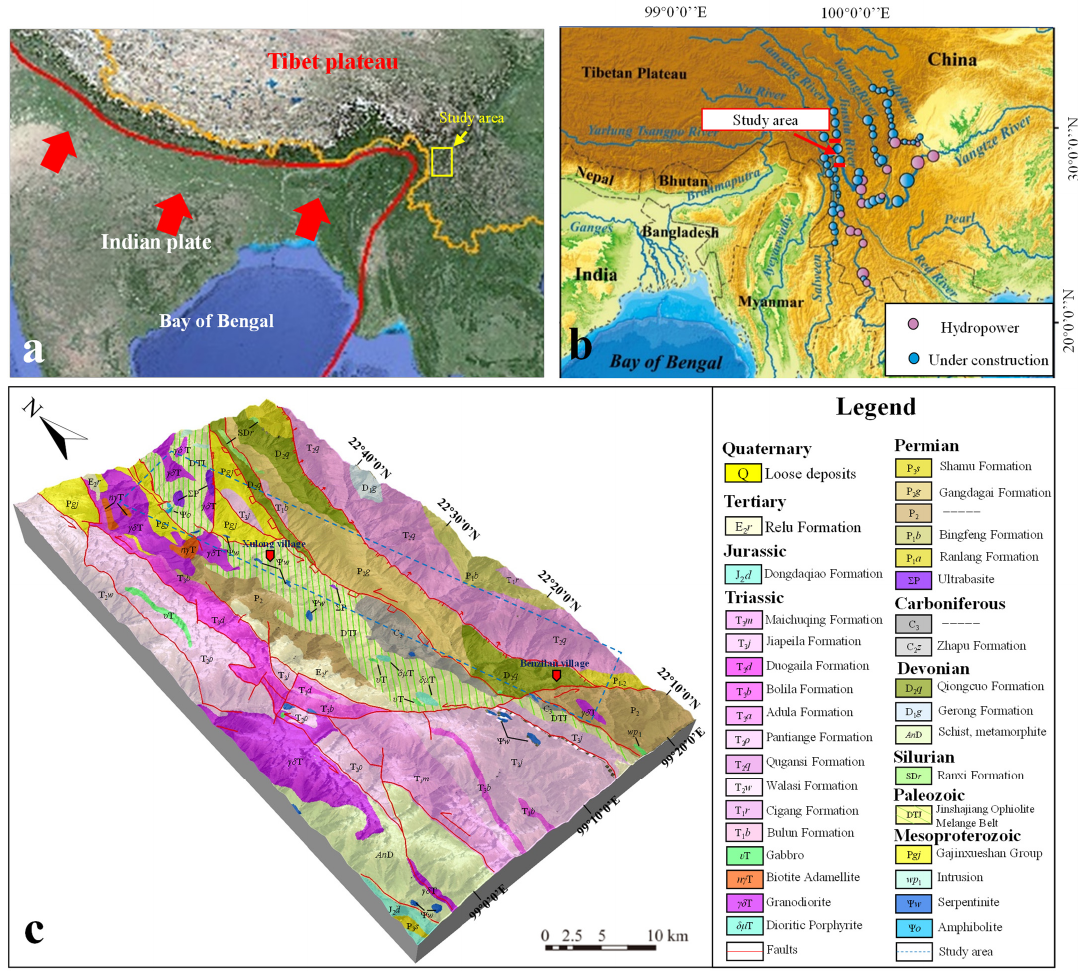
Figure 1. The geological and tectonic setting of the study area. ( a ) The location of the study area, ( b ) distribution of large hydropower projects in southwest China [11], and ( c ) geological map of the study area [11].